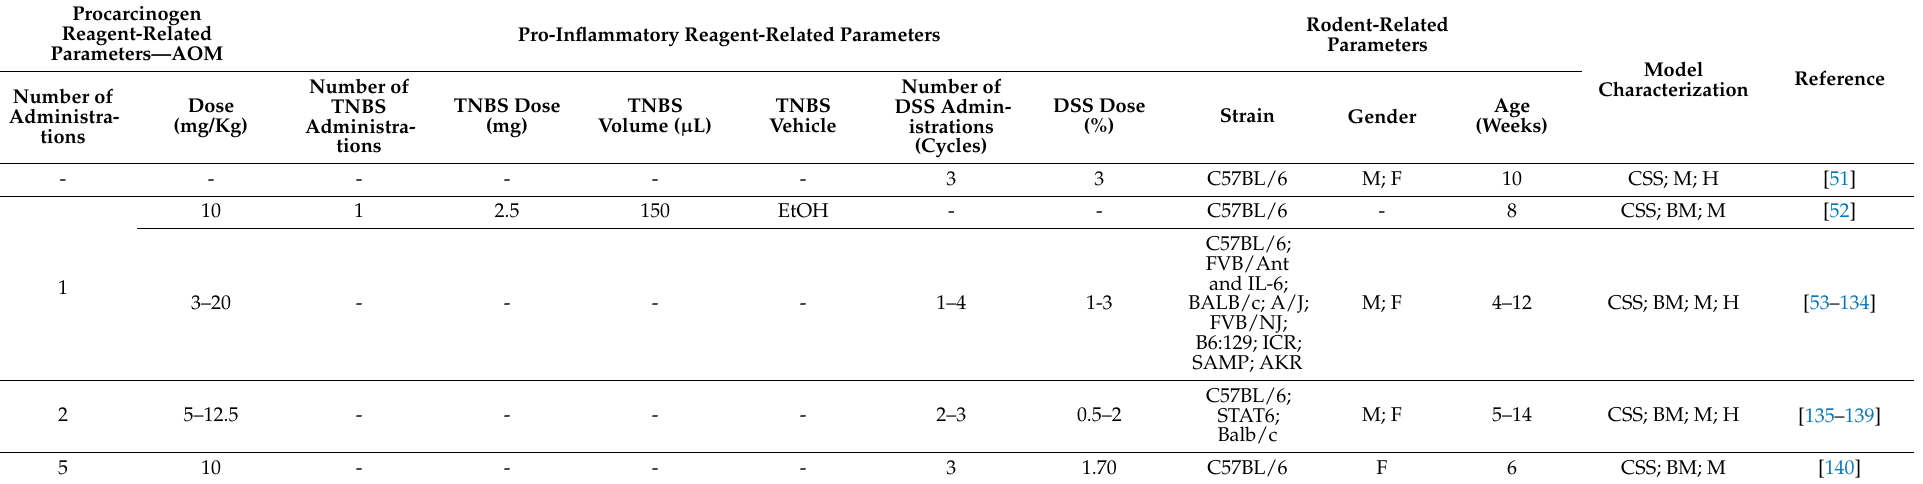
Table 1. Summarized outcomes of induction methods for CACC